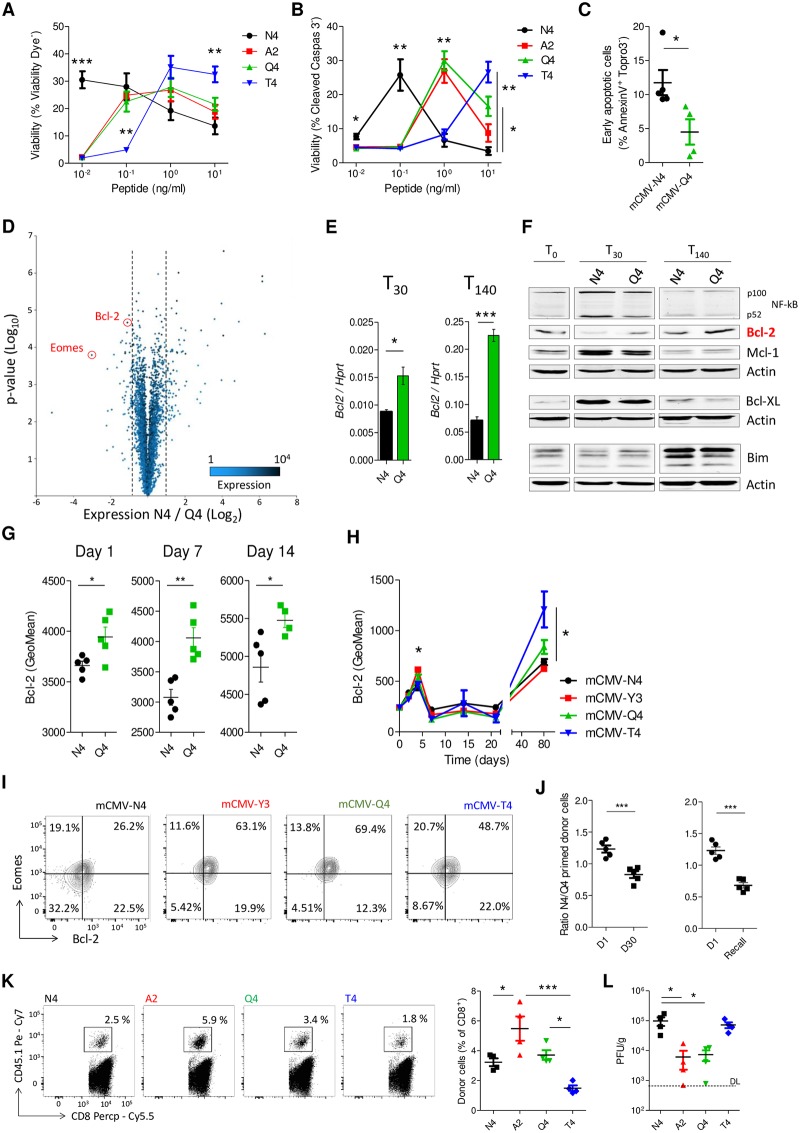
Memory precursors of suboptimal affinity express higher Bcl-2 protein levels.(A,B) Purified OT-1 cells were primed for 30 hours with indicated peptides and anti-CD28. Next, cells were washed and cultured for an additional 5 days with 50 ng/ml of IL-15. Shown is viability of cells on day 6 after stimulation primed with the indicated concentrations of peptides determined by staining for (A) viability dye or (B) cleaved caspase-3. (C) CD45.1+ OT-1 cells (104) were transferred to WT CD45.2+ recipients. After 24 hours, mice were infected with mCMV-N4 or mCMV-Q4. Apoptosis was assessed on day 14 in donor cells from spleen by flow cytometry. (D-G) Purified OT-1 cells were primed for 30 hours with 1 ng/ml N4 or Q4 peptides and anti-CD28. Next, cells were washed and cultured for an additional 5 days with 50 ng/ml IL-15 to generate memory cells. (D) Differential expression was analyzed by microarray. Graph shows a volcano plot on day 6 of stimulation. Dashed lines indicate 2-fold differential expression. (E-F) Thirty (T30) and 140 (T140) hours after start of the experiment, cells were analyzed by (E) qPCR and (F) western blot. (G) On day 6 of stimulation, 1 × 106 OT-1 cells (CD45.1+) were transferred to WT recipients (CD45.2+) and on the indicated time points after transfer expression of Bcl-2 was determined in donor cells in spleen by flow cytometry. (H,I) CD45.1+ OT-1 cells were transferred in WT (CD45.2+) recipients. After 24 hours, mice were infected with mCMV expressing the indicated peptides. (H) Quantification of the GeoMean of Bcl-2 in donor cells at the indicated days. See also S5E Fig. (I) Representative FACS plots show Eomes and Bcl-2 expression on day 4 after infection gated for CD8+CD45.1+ cells. (J) Memory OT-1 cells were generated in vitro after priming with N4 or Q4 peptides using CD45.1+ or CD45.1/2+ cells, respectively. On day 6 of stimulation, cells were mixed in equal proportions, and 1.4 × 106 cells were transferred to WT recipients (CD45.2+). On days 1 and 30 after transfer, the ratio between donor cells in spleen was determined by flow cytometry (left panel). The same cell mixtures were transferred to WT recipients (CD45.2+) at 25,000 cells per recipient, and after 30 days, mice were infected with mCMV-N4. On days 1 and 37 after transfer, the ratio between donor cells in spleen was determined by flow cytometry (right panel). (K-L) Memory CD45.1+ OT-1 cells were generated in vitro using the indicated peptides for priming. On day 6 of stimulation, 25,000 viable OT-1 cells were transferred to naïve CD45.2+ recipients. After 47 days, mice were infected with mCMV-N4. (K) Donor-cell numbers were determined in spleen on day 5 after infection by flow cytometry. Representative FACS plots are gated for CD8+ cells. (L) Virus titers were determined in liver on day 3 after infection by plaque assay. Experiments show representative data from at least two (E,G, J-L), three (F), or four (A-C,H,I) independent experiments using 3–5 mice per group. (D) Data of microarray analysis of three biologically independent samples, each pooled from 3–4 mice. In (A,B,H,K,L), ANOVA followed by Bonferroni posttesting; in (C,E,G,J), Student t test; and in (L), Kruskal-Wallis test were used to analyze difference between groups. Shown are means ± s.e.m. *P < 0.05, **P < 0.01, ***P < 0.001. Values for each data point can be found in S1 Data. A2, SAINFEKL; DL, detection limit; FACS, fluorescence-activated cell sorting; GeoMean, geometric mean; IL, interleukin; mCMV, murine cytomegalovirus; N4, SIINFEKL; qPCR, quantitative polymerase chain reaction; PFU, plaque-forming units; Q4, SIIQFEKL; T4, SIITFEKL; WT, wild-type.